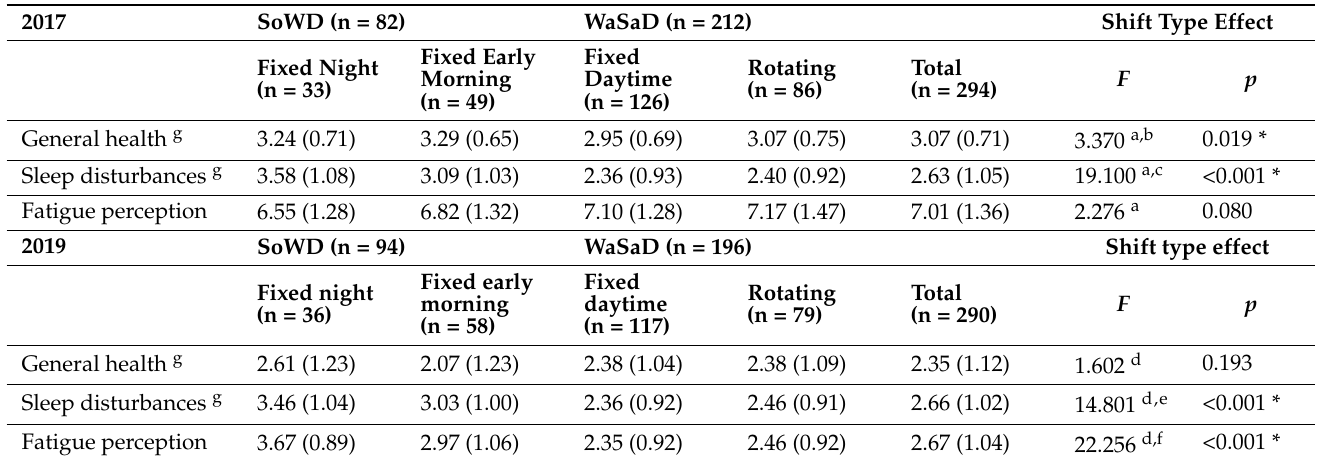
Table 6. Mean (SD) for general health, fatigue perception and sleep disturbances variables in 2017 and 2019 by shift type and shift types comparisons.